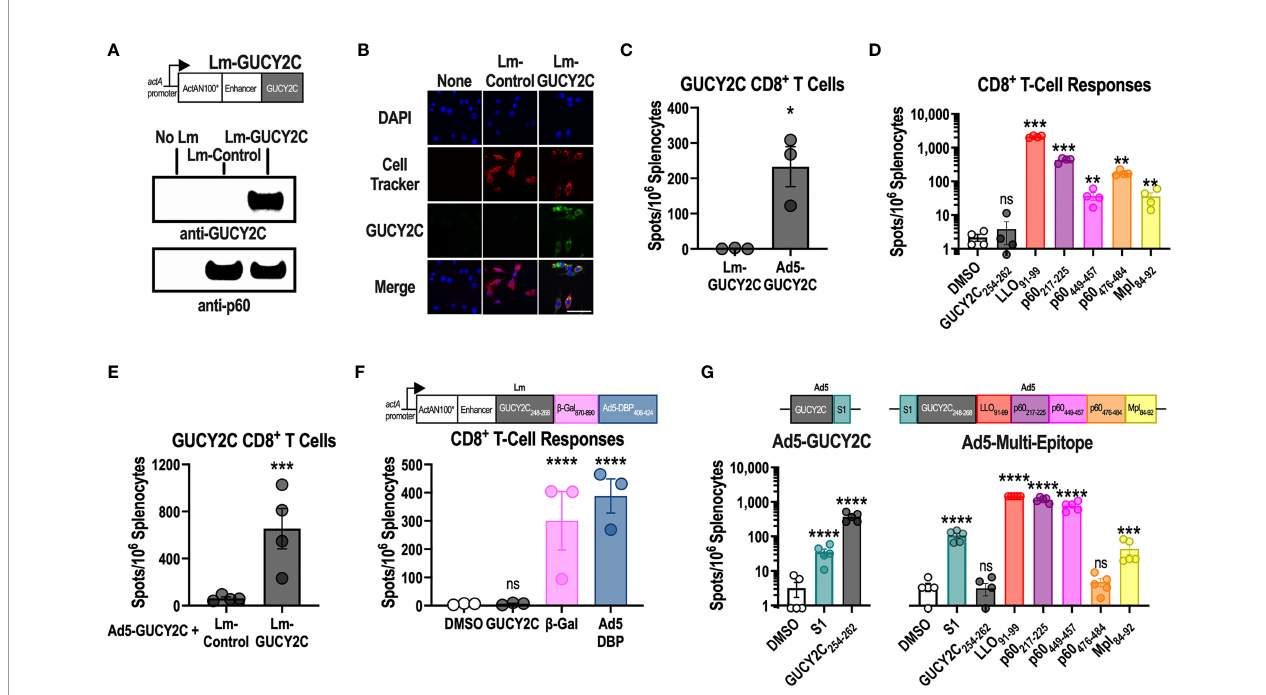
FIGURE 1 | GUCY2C 254-262 peptide is subdominant to Lm-derived peptides. (A) Lm-GUCY2C secretes a fusion protein comprised of ActAN100*, an enhancer sequence, and mouse GUCY2C 23-429 under control of the actA promoter. (A, B) J774A.1 macrophages were uninfected or infected with Lm-Control or Lm-GUCY2C at a 10:1 MOI for 6 h at 37°C. GUCY2C fusion protein was detected by (A) western blot and (B) immuno fl uorescence. Scale bars in B are 50 um. (C, D) BALB/c mice (n=3-4/group) were immunized intraperitoneally (i.p.) with 10 7 colony-forming units (CFU) of recombinant Lm secreting GUCY2C (Lm-GUCY2C) or intramuscularly (i.m.) with 10 10 vp of Ad5-GUCY2C. (E) Animals received 10 7 CFU of Lm-GUCY2C or Lm-Control 21 d after priming with 10 10 vp of Ad5-GUCY2C. (C – E) Fourteen days after Ad5-GUCY2C immunization or 6-7 d after Lm administrations, mice were euthanized, and splenocytes were collected to quantify GUCY2C 254-262 (C, E) or Lm- speci fi c (D) T-cell responses, quanti fi ed by IFN g ELISpot. (F) BALB/c mice (n=3) were immunized with an Lm containing a multi-epitope construct composed of GUCY2C, b -Gal, and Ad5 DBP epitopes (as depicted), and those responses were quanti fi ed 7 d later by IFN g ELISpot. (G) BALB/c mice (n=5/group) were immunized with Ad5-GUCY2C (left) or a recombinant Ad5 containing S1, GUCY2C 254-262 , and the H-2K d -restricted Lm epitopes as depicted (right). Responses were quanti fi ed 14 d later by IFN g ELISpot. Statistical comparisons were made by unpaired T test (C, E) or one-way ANOVA with Bonferroni correction for multiple comparisons of epitope-speci fi c response to control DMSO wells (D , F , G) . Error bars indicate mean +/- SEM. Symbols indicate individual animals. *P < 0.05; **P < 0.01; ***P < 0.001; ****P < 0.0001; ns, not signi fi